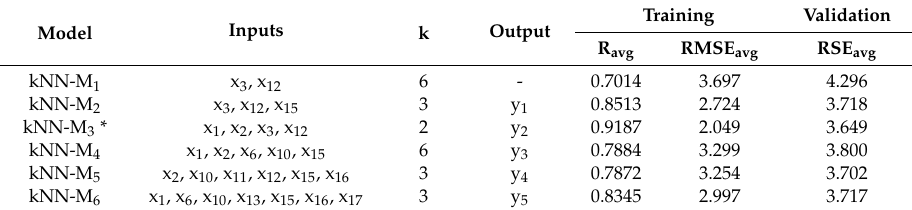
Table 1. Select kNN models using Mahalanobis distance functions.